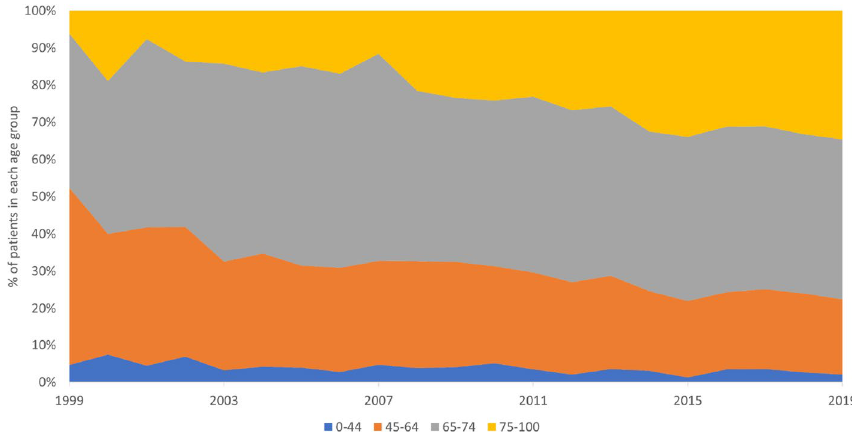
Figure 6. Age-specific incidence rates for NMSC between 1999 and 2019.